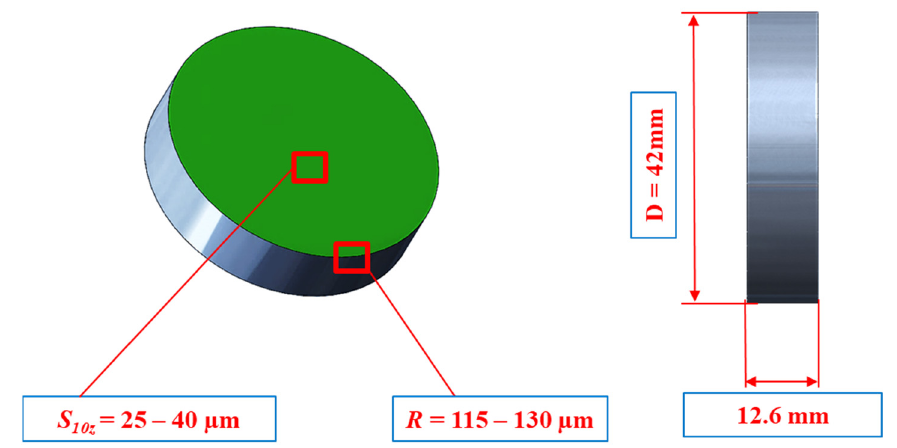
Figure 1. Geometry of ZnO varistor used in milling and AWJ cutting operations.